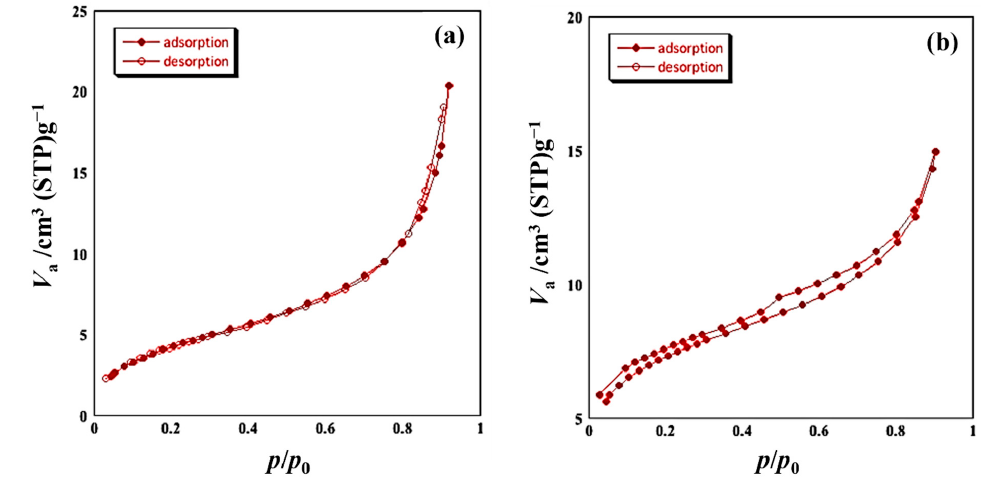
Figure 4. Nitrogen adsorption isotherms of samples A ( a ) and B ( b ) measured at 77K.